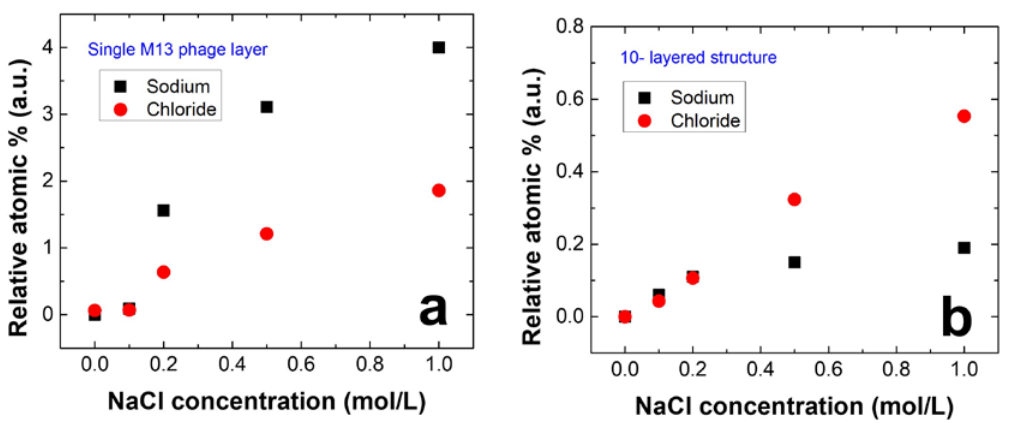
Figure 4. Calculated relative atomic percentages obtained from X-ray photoelectron spectroscopy (XPS) measurements for ( a ) M13 phage only and ( b ) 10-layer M13 phage-PDDA nanoporous biofilms, which confirm selective ion filtration.